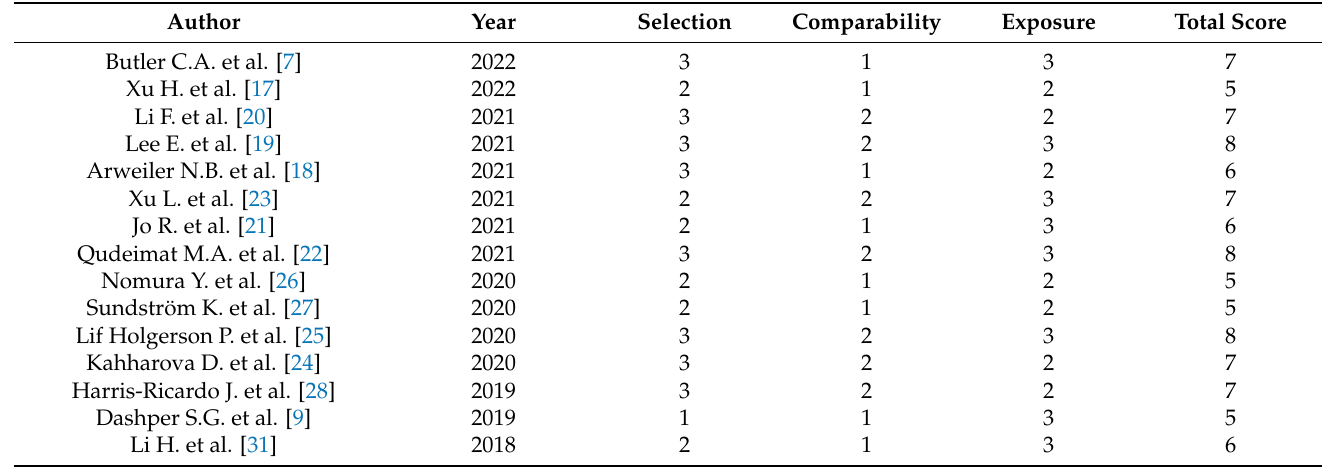
Table A1. Newcastle-Ottawa Quality Assessment Scale. Possible total points were 4 points for selection, 2 points for comparability, and 3 points for exposures